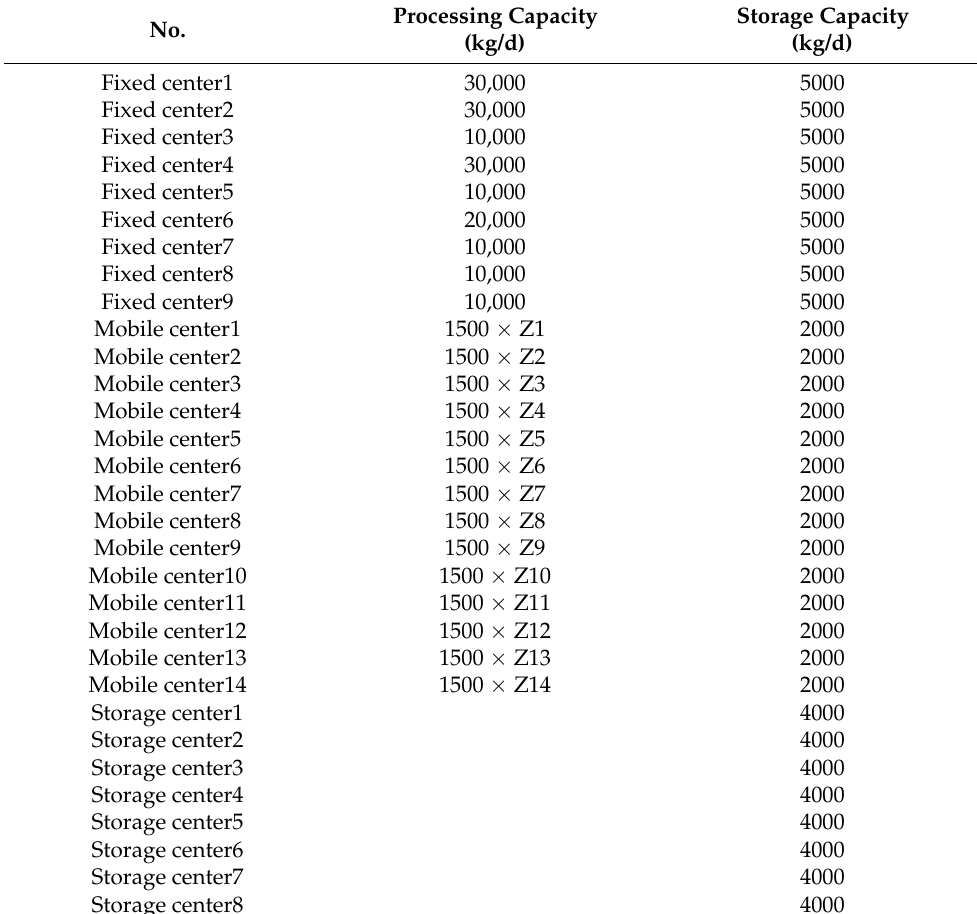
Table 3. Capacity